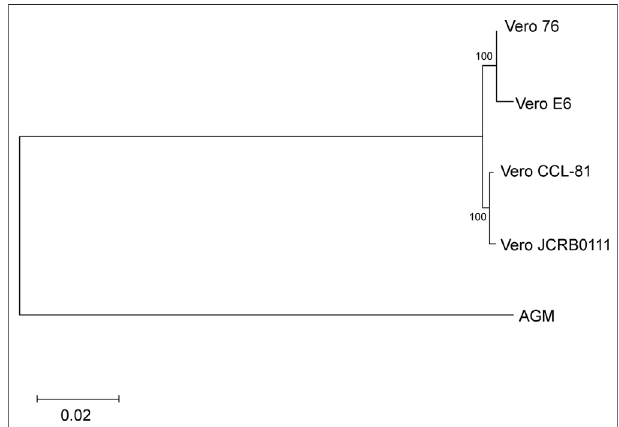
FIGURE 4 | Cladogram of the four Vero sublines. The genetic distances were measured using f 2 statistics and the neighbor-joining method was used for the tree reconstruction. Bootstrap % values are shown on the blanches.